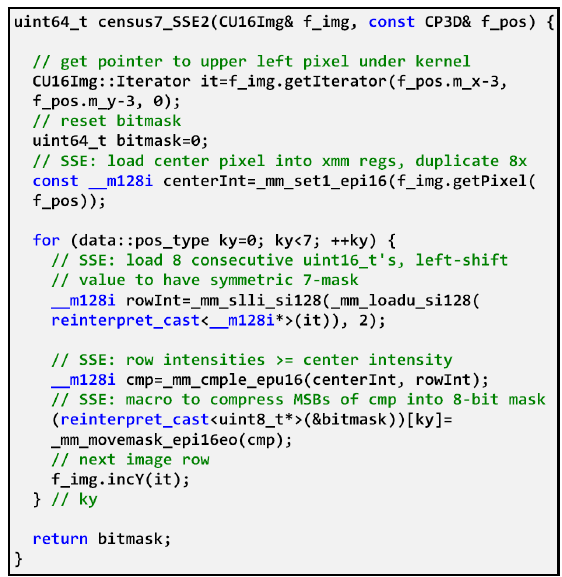
Figure 4. C++ code with SSE2 intrinsics for the census